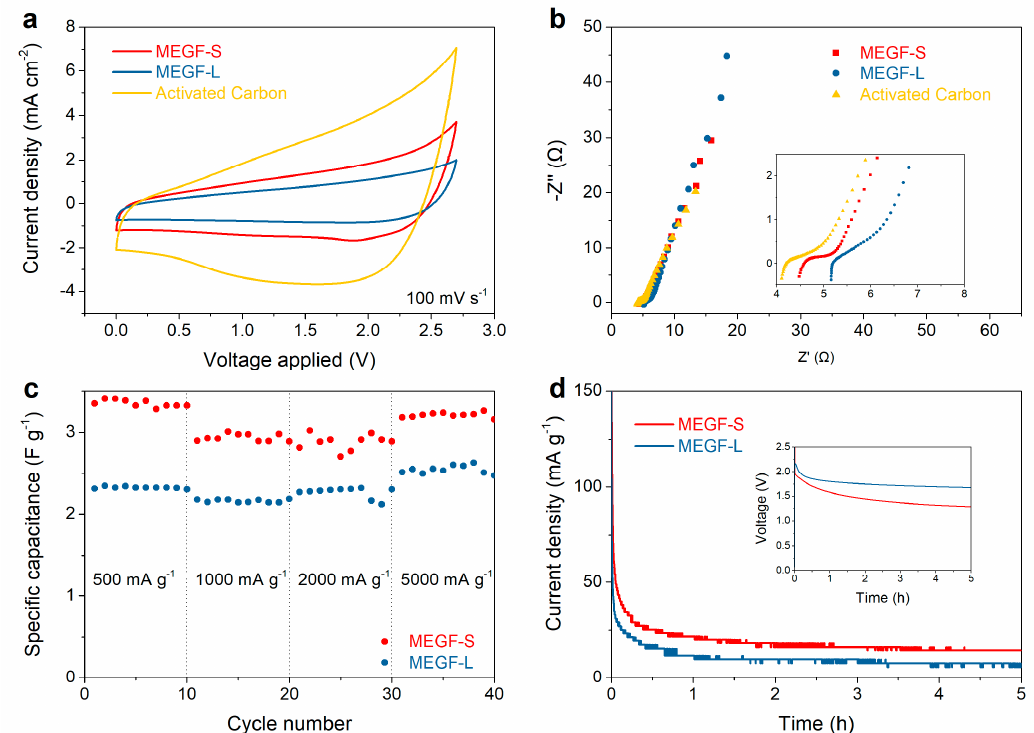
Figure 6. Comparison of the electrochemical performance for MEGF-S, MEGF-L, and activated carbon: cyclic voltammograms acquired at 100 mV s − 1 ( a ), Nyquist plots ( b ), specific discharge capacitance at increasing current intensities ( c ), and voltage hold tests at 2.5 V (inset: self-discharge curves after charging the devices to 2.5 V) ( d ).